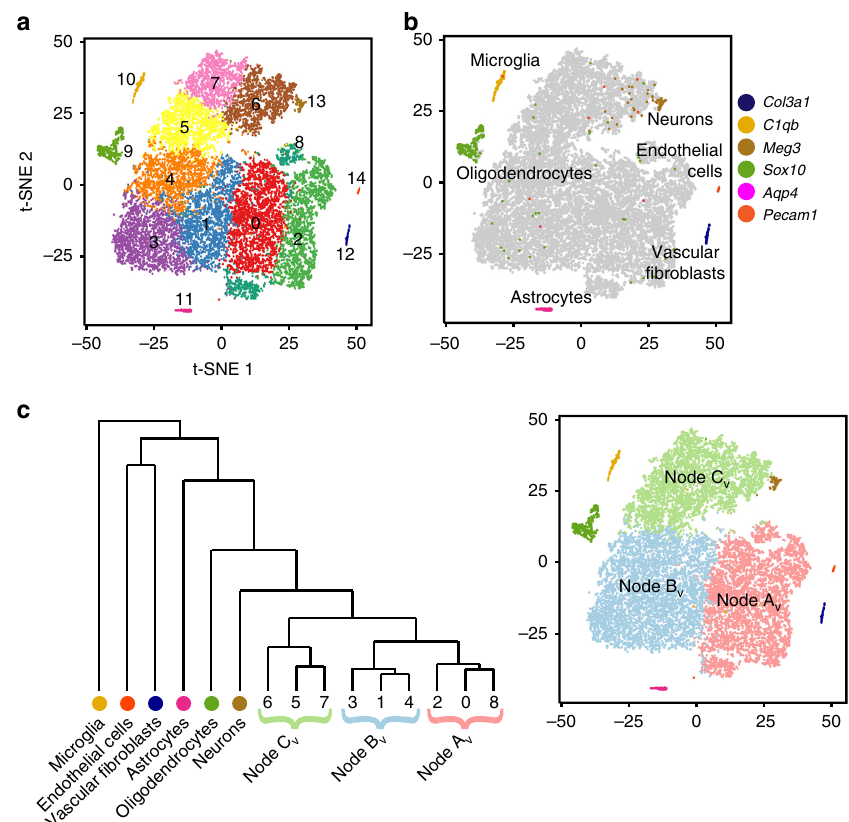
Fig. 2 Single-cell transcriptomic analysis identi fi es discrete types of cells. a t-SNE projection of cells from fi ve vehicle-treated tumors, with cells placed according to Euclidean distance from each other in ten-dimensional PCA. The color code indicates clusters. b Feature plot of indicated vascular, microglial and glial markers on the t-SNE projection in a . c Dendrogram showing relationship of Nodes A V – C V de fi ned by HCA and t-SNE projection as in a , color- coded for Nodes and identi fi ed cell types. Thresholds for all feature plots are listed in Supplementary Dataset